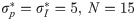
BNI as function of coupling strength and distance to the SNIC bifurcation.The left and right columns correspond to the WM and CM, respectively. The resemblance between the two surfaces suggests that the CM is a good parsimonious model of WM for the of study BNI. The red lines on the surfaces correspond to BNIpre = 0.5. The surfaces in panels (a) and (b) represent an average over an ensemble of 10 directed random networks, and the error bars in panels (c)-(f) account for the variability of BNI between different network realizations. Parameters: σp*=σI*=5,N=15, and c = 1.6. Additionally, in panels (c) λ* = 1.09, (d) w* = 1.33, (e) pc−p0 = 1.45, and (f) Ic−I0 = 1.62.